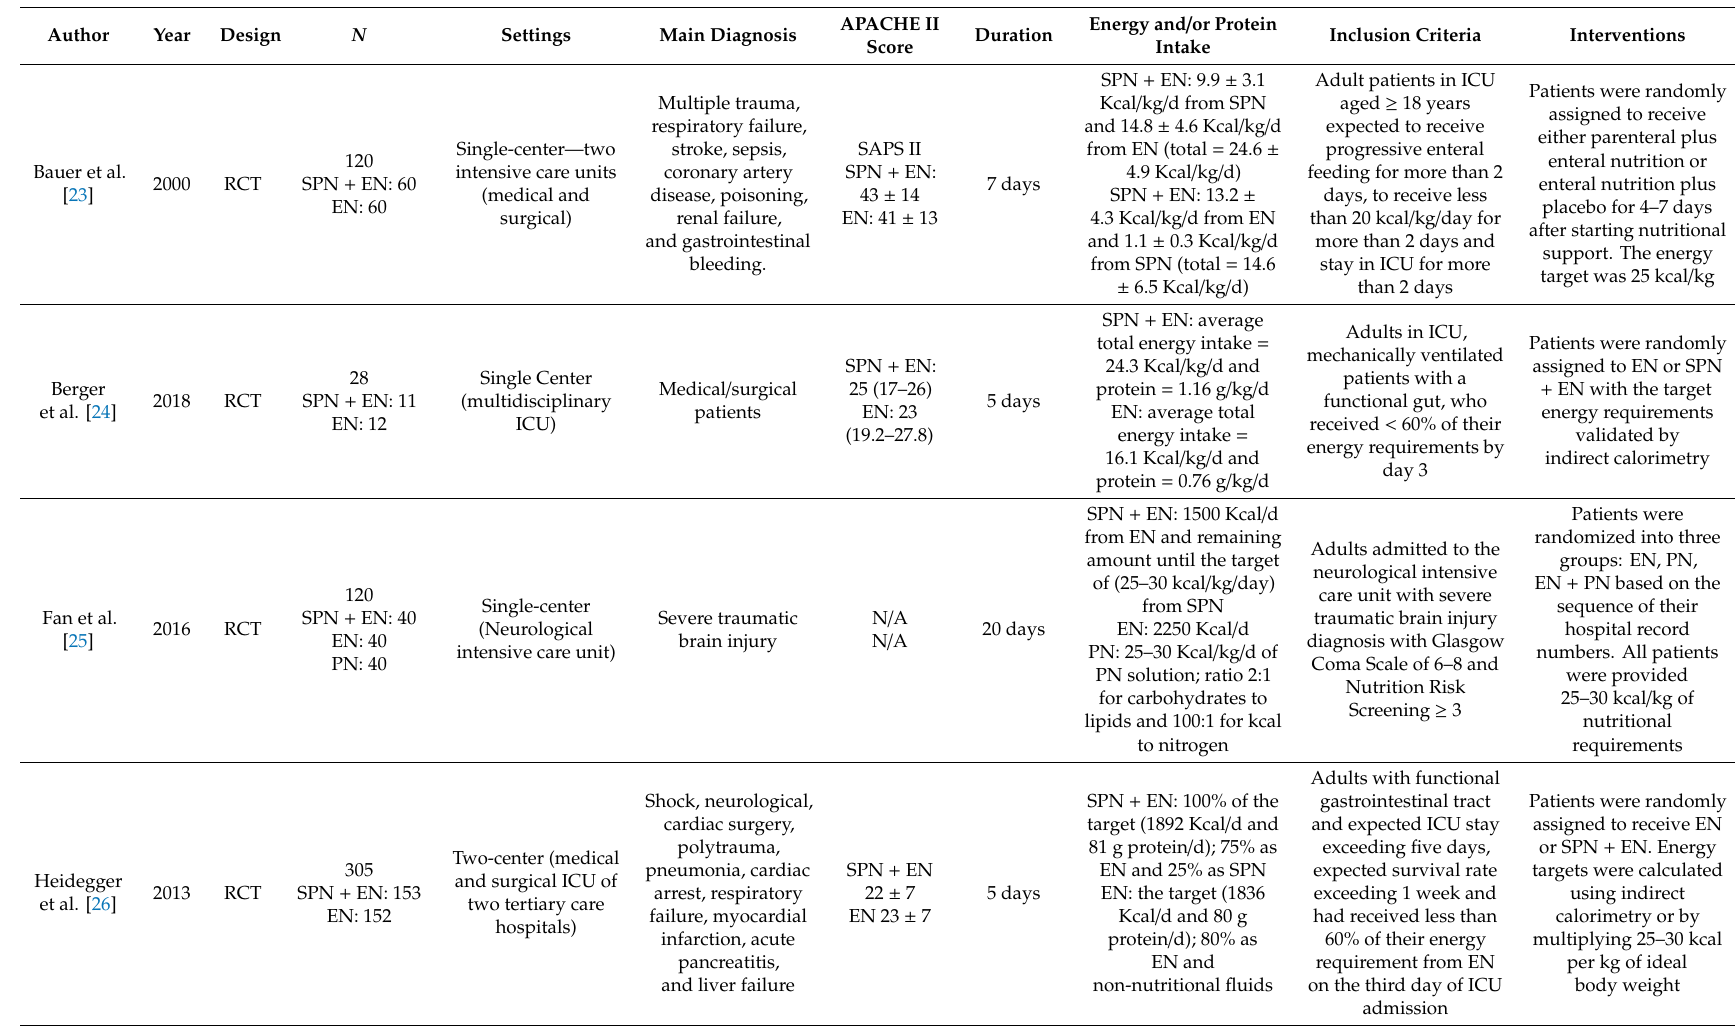
Table 1. Characteristics of the included